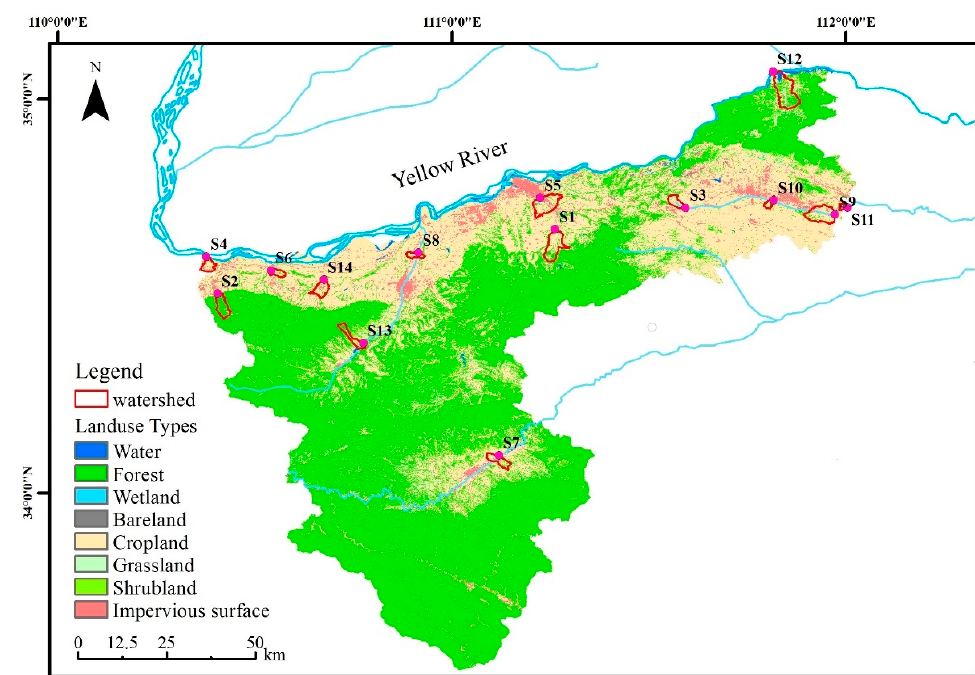
Figure 2. The land use types of the study area.